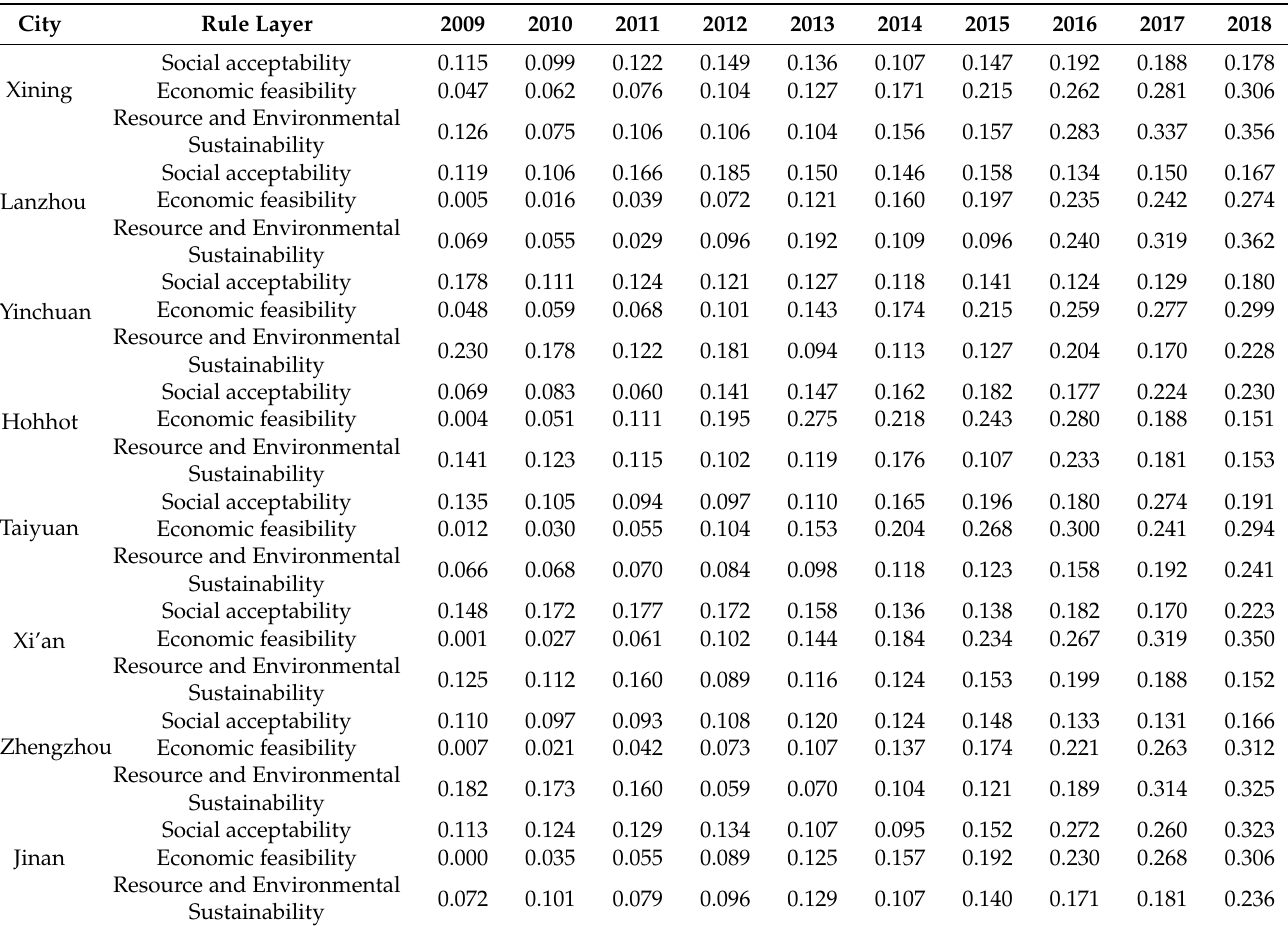
Table 5. Score of each rule layer for SLU in central cities of the Yellow River Basin,